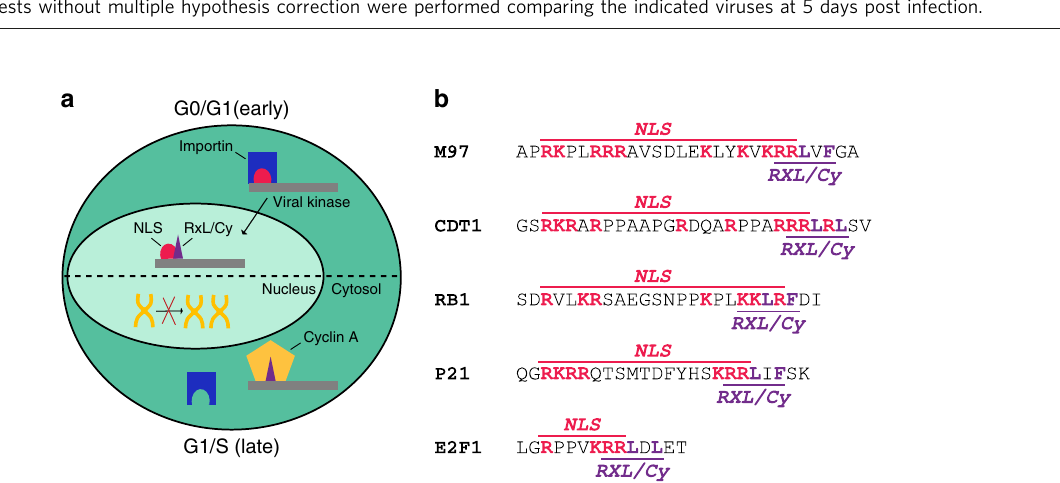
Fig. 5 M97 causes shutoff of host DNA synthesis by Cyclin A sequestration. Serum-starved 3T3 cells were infected with the indicated recombinant viruses and subjected to subcellular fractionation ( a ), cell cycle analysis ( b , c ), or confocal microscopy ( d ). a The levels of Cyclin A, E, and Cdk2 proteins was determined at 24 h post infection in nuclear and cytosolic fractions by immunoblotting. The soluble viral nuclear protein IE1 and the cytosolic marker GAPDH served as controls. The immunoblots are representative of three independent experiments with similar results. b , c The DNA content of infected cells was analyzed by propidium iodide staining followed by fl ow cytometry and plotted as DNA histograms. b The accumulation of viral and cellular DNA was monitored over the time course of infection. c To discriminate viral from cellular DNA replication, infected cells were treated with ganciclovir (GCV) or left untreated. d , e At 30 hpi, infected cells were pulse-labeled with EdU. EdU staining via click-chemistry (green fl uorescence) served to determine sites of cellular and viral DNA synthesis. EdU was combined with immuno fl uorescence detection of the viral replication factor M57 (red fl uorescence) that marks sites of viral DNA synthesis. DAPI was used for nuclear counterstaining (blue fl uorescence). Scale bars: 10 μ m. e The indicated number of cells were categorized based on the (co-)localization of EdU and M57 fl uorescence within the nucleus. f Mouse embryonic fi broblasts were infected with the indicated viruses at an MOI of 0.02. At the indicated days post infection, the infectious supernatant was harvested and subjected to virus titration. Means (center of the error bars) and standard errors of the mean of n = 3 (3, 5, 7 days post infection) biological replicates are depicted. For 0 days post infection: n = 2. Two-sided t -tests without multiple hypothesis correction were performed comparing the indicated viruses at 5 days post infection.